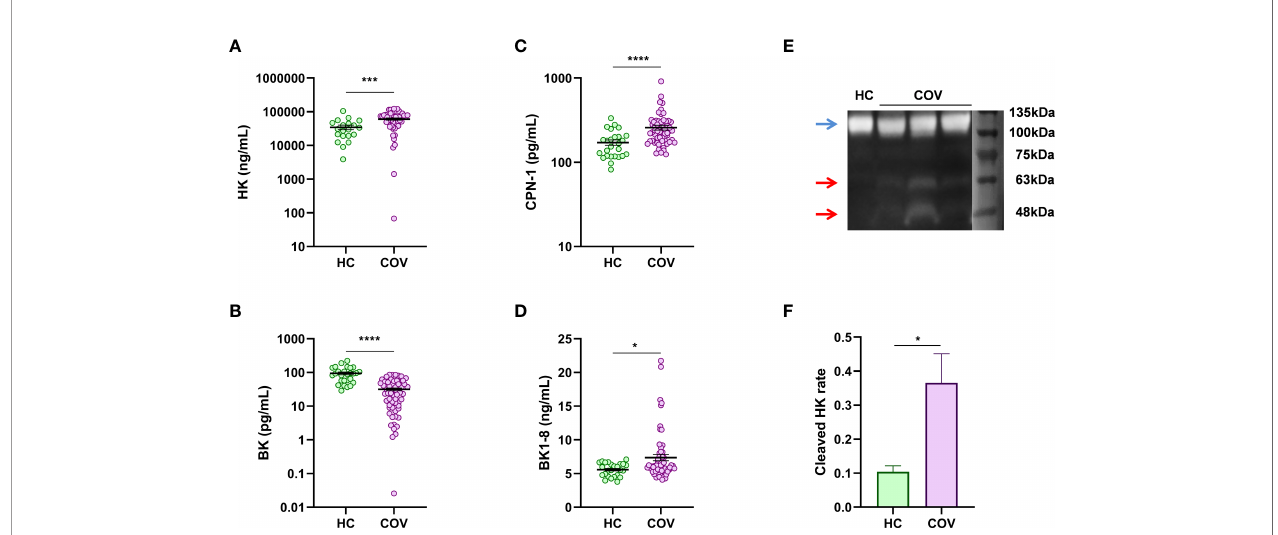
FIGURE 1 | Plasma levels of KKS components. ELISA quanti fi cation in plasma from healthy controls (HC) and patients with COVID-19 (COV) of (A) HK (HC, n = 20; COV, n = 49), (B) BK (HC, n = 27; COV, n = 63), (C) BK1-8 (HC, n = 27; COV, n = 63), and (D) CPN1 (HC, n = 26; COV, n = 61). (E) Representative Western blot of plasma of healthy control (HC) and patients with COVID-19 patient (COV) (blue arrow, band at approximately 110 kDa is an intact 1-chain HMWK; red arrows, bands at approximately 46 and 56 kDa are cleaved 2-chain HMWK). (F) Cleaved 2-chain HK expression relative to intact-1chain HK expression in plasma from healthy controls (HC, n = 4) and patients with COVID-19 (COV, n = 8) measured by densitometry quanti fi cation of bands from Western blot. Mean differences were analyzed by Mann – Whitney U-test. Error bars: mean ± SEM. * P < 0.05; *** P < 0.001; **** P <